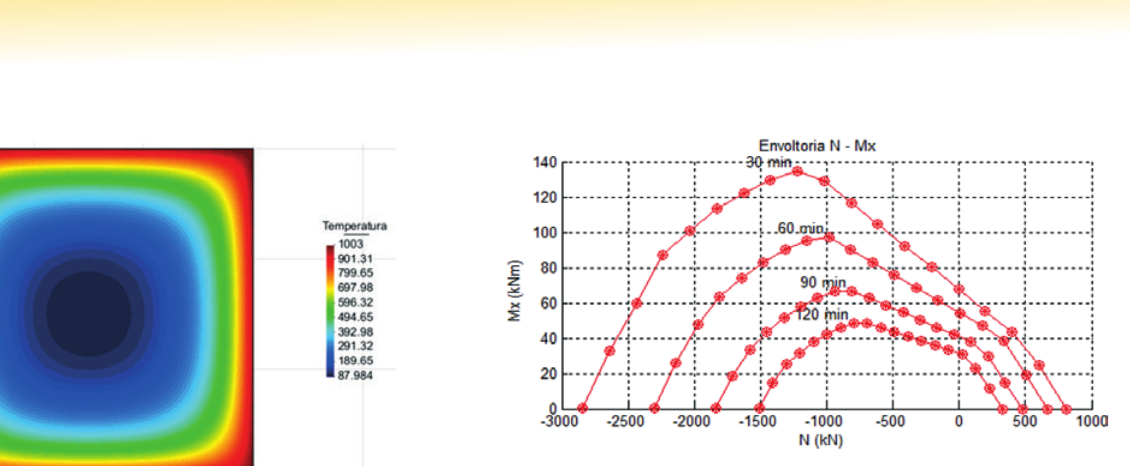
Figura 16b Curvas de interação N x M